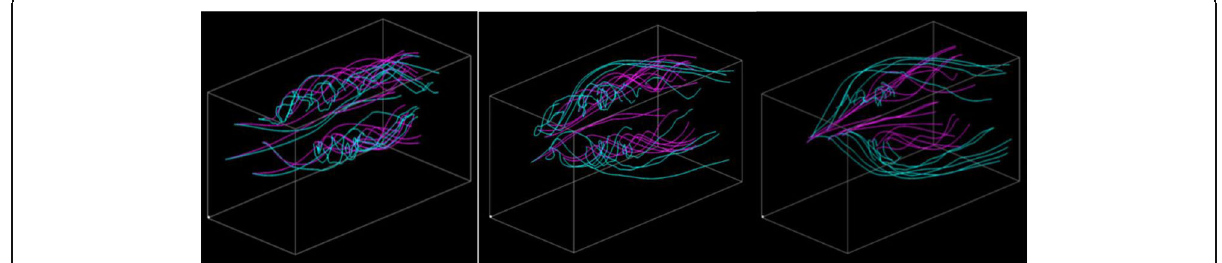
Fig. 10 Visualization with various α values. (Left) Only the geometric entropy is applied ( α = 1.0). (Center) Both the geometric entropy and distance of streamline pair is applied ( α = 0.5). (Right) Only the distance of streamline pair is applied ( α =